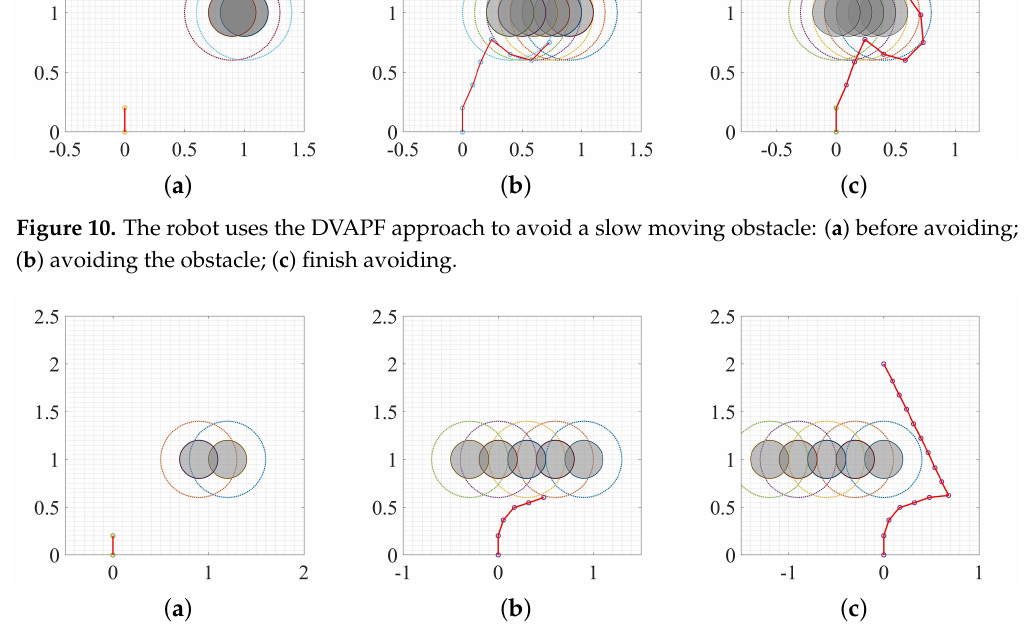
Figure 11. The robot uses the DIAPF approach to avoid a fast moving obstacle: ( a ) before avoiding; ( b ) avoiding the obstacle; and ( c ) finish avoiding.